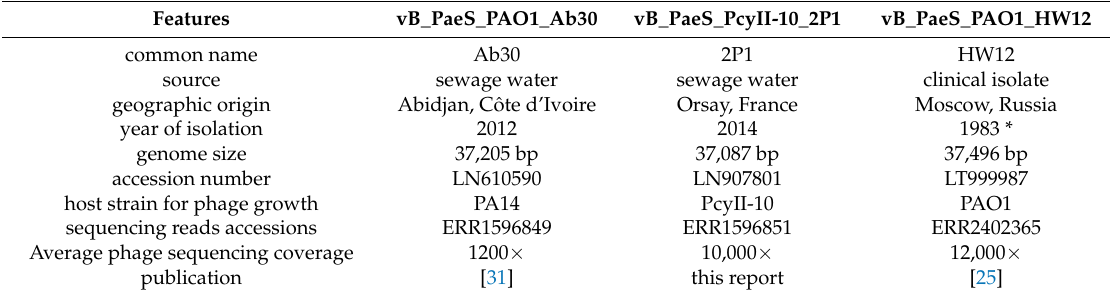
Table 1. Main characteristics of phages Ab30, 2P1, and